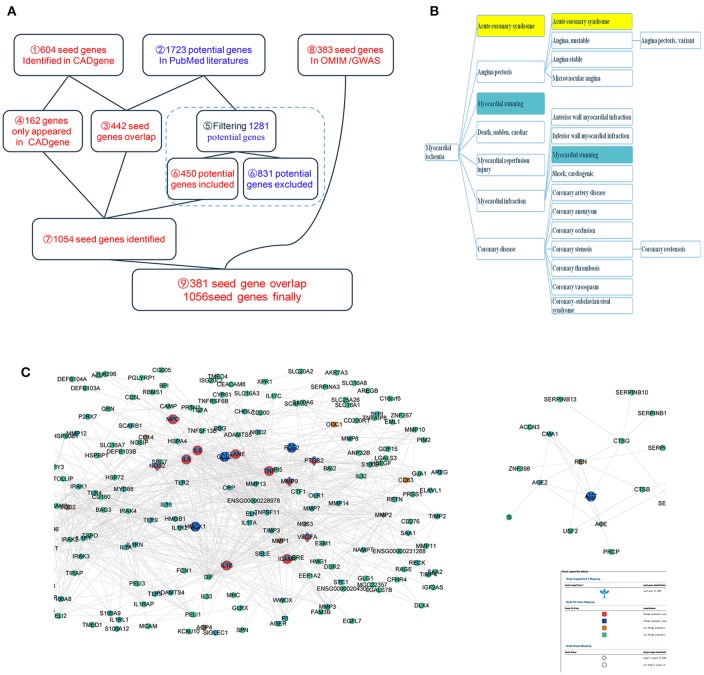
The main results of the study. (A) The steps and process how ischemic heart disease associated genes formed. (B) The upper and down relationships between the MeSH headings of ischemic heart disease (IHD). (C) Modules 195 and 95 representing phlegm-stasis cementation syndrome (PSCS) with ischemic heart disease (IHD) (syndrome modules).